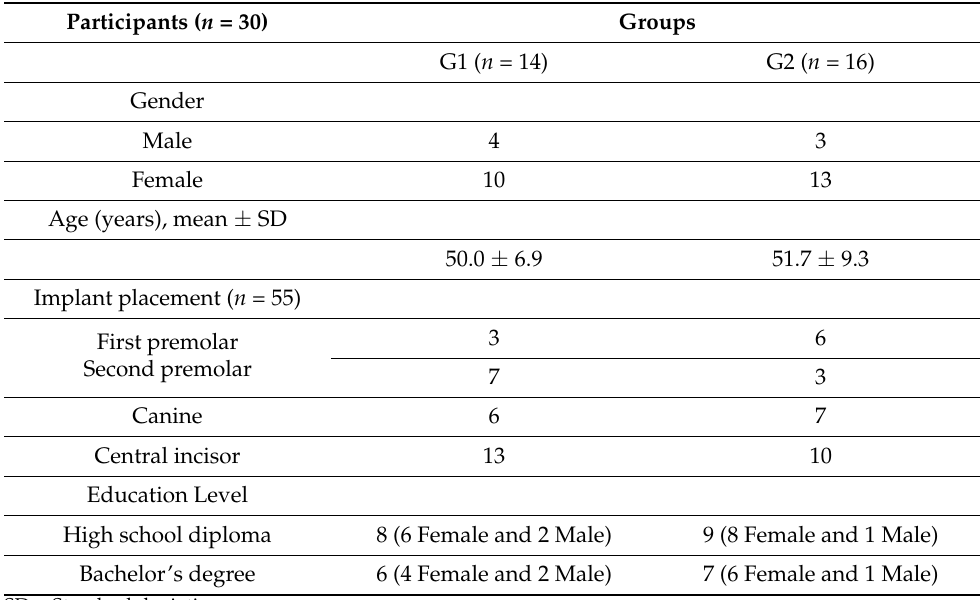
Table 2. Socio-demographic data of the patients included in the study.